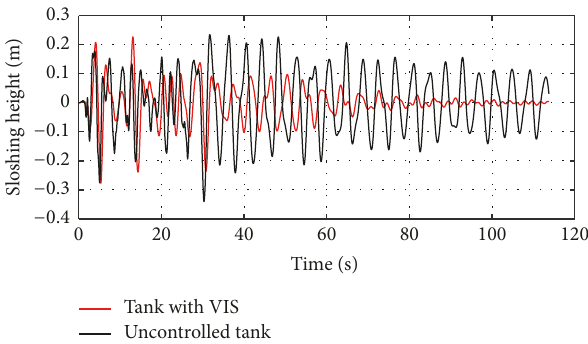
Figure12:Dynamicresponsesofthesloshingheightofthetankwith the VIS under the excitation of the Kobe